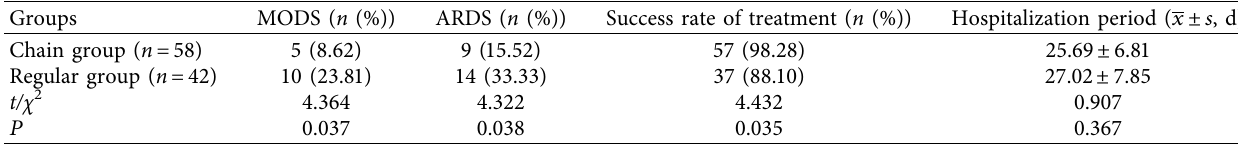
Table 3: Comparison of prognosis between two groups.